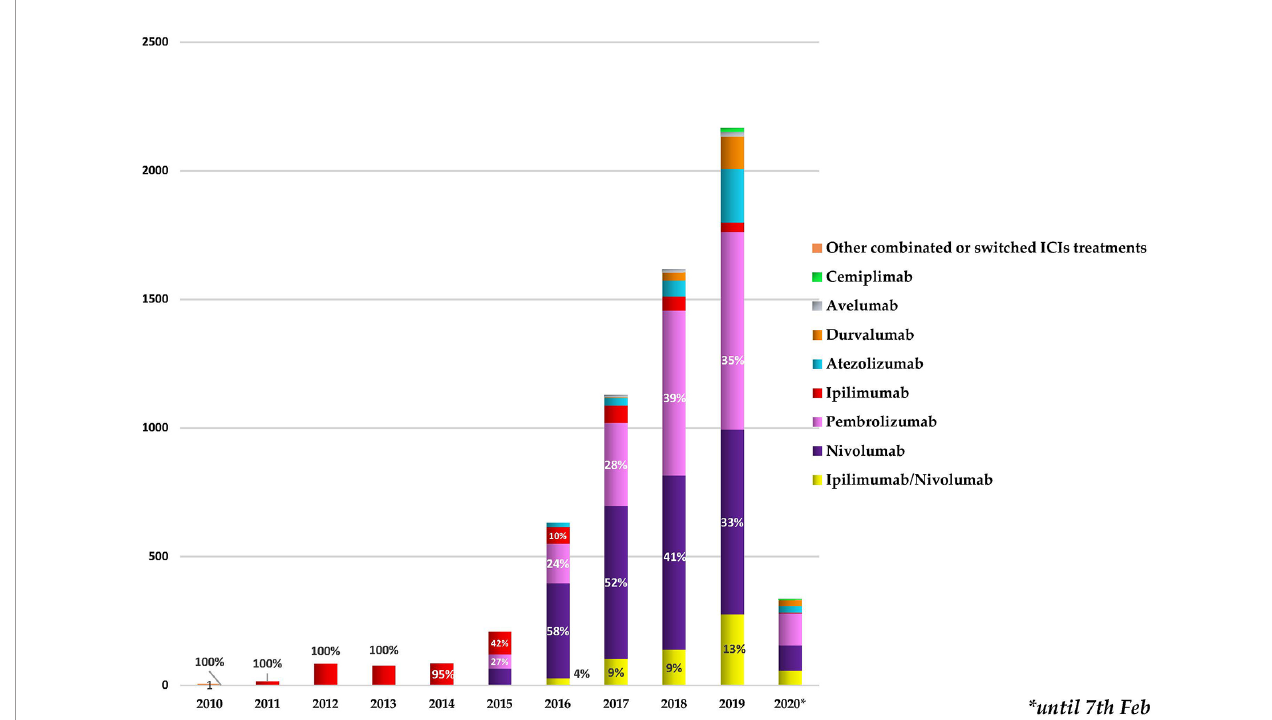
FIGURE 1 | Annual trend for neurologic outcomes occurring in cancer patients treated with one or more immune checkpoint inhibitors (ICIs), categorized by years and administrated ICI treatments. The percentages of the fi rst 3 treatments most involved in the neurological events collected each year are reported. * stands for the date 7th Feb